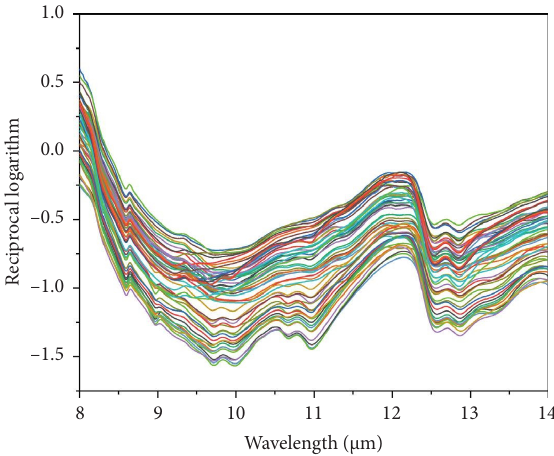
Figure 3: Absorption spectra by reciprocal logarithm.